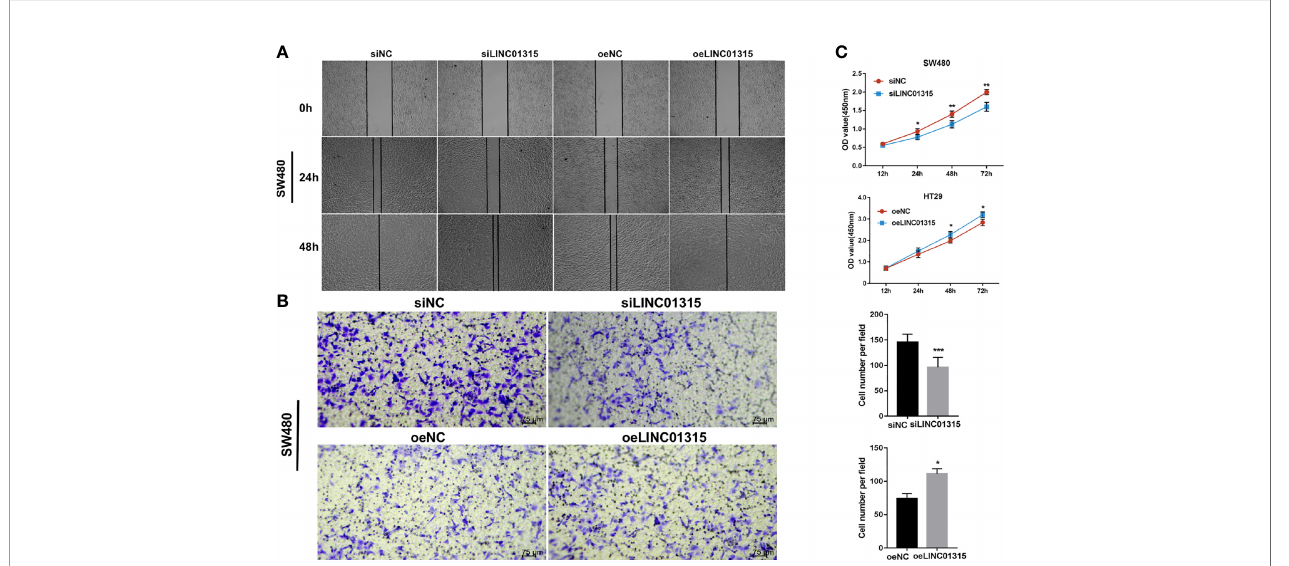
FIGURE 10 | Functional validations of one candidate lncRNA: LINC01315 promotes proliferation and migration of colon cancer cells in vitro. SW480 and HT29 cell were selected and transfected with siLINC01315 and overexpression vector. Evaluation of migration and proliferation capacity by wound healing assay (A) , transwell assay (B) and CCK-8 assay (C) . (*P < 0.05, **P < 0.01, ***P <